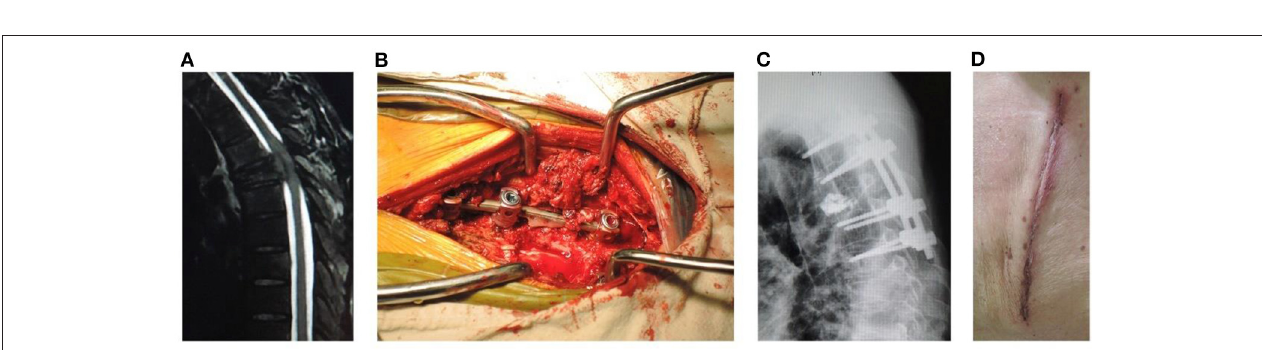
FIGURE 1 | (A) Photography showing freehand minimally invasive pedicle screw fixation. (B) Injection of cement into the target vertebral body under fluoroscopic guidance. (C) Minimally invasive neurologic decompression and partial tumor resection.